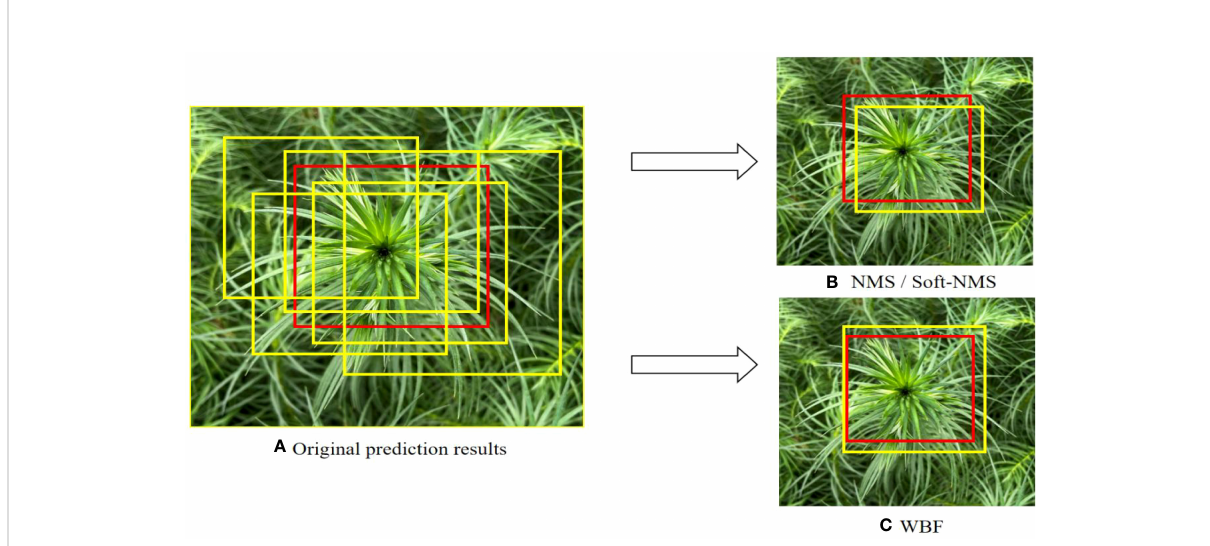
FIGURE 6 Schematic diagram of Non-maximum inhibition (NMS), Soft-NMS, and Weighted Box Fusion (WBF). The red box is the real boundary box of the terminal bud of Chinese fi r seedlings, and the yellow box is the model prediction box. (A) Original prediction results, (B) NMS / Soft-NMS, (C) WBF.